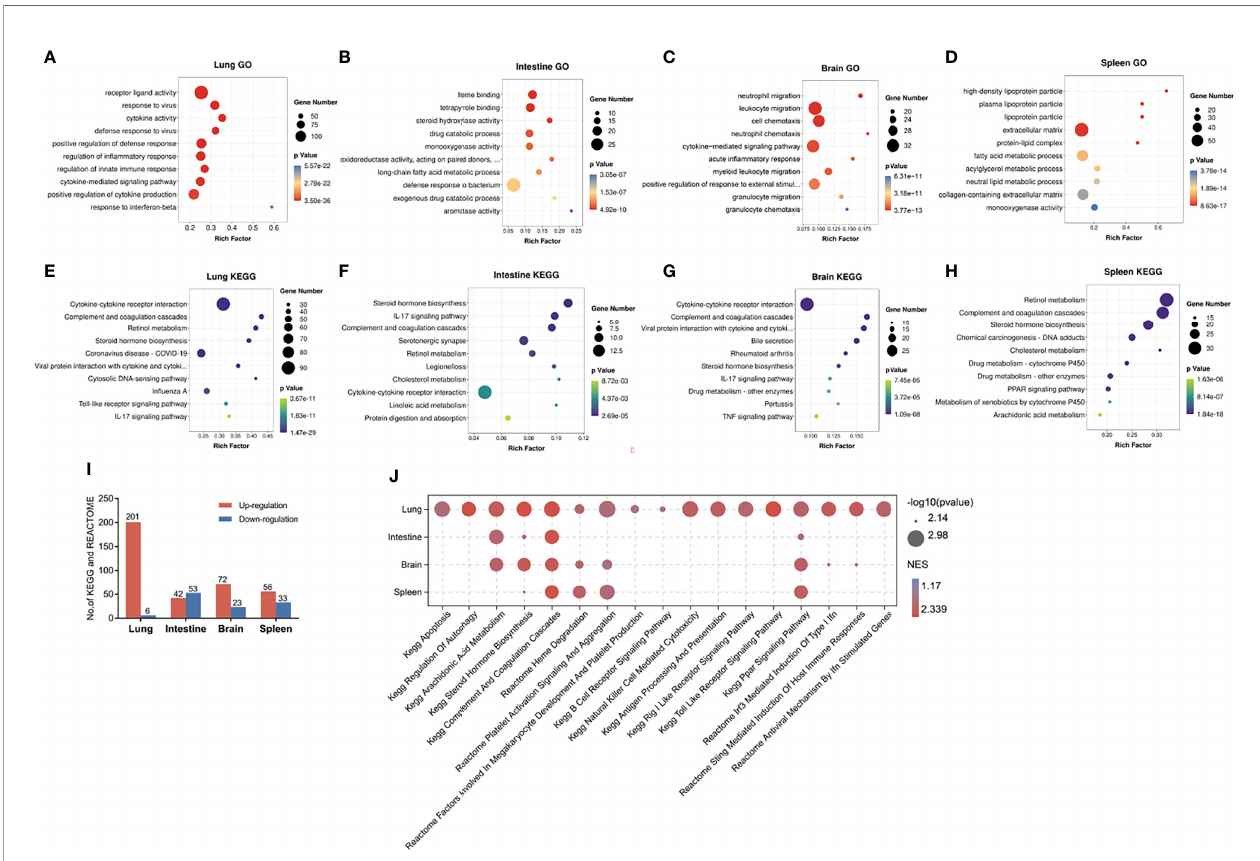
FIGURE 2 | Enrichment analysis of DEGs in lung, intestine, brain, and spleen of RSV-infected mice. (A – D) Top 10 enriched GO terms in DEGs in lung, intestine, brain, and spleen, respectively. (E – H) Top 10 enriched KEGG pathways in DEGs in lung, intestine, brain, and spleen, respectively. An adjusted p- value < 0.05 was considered signi fi cant in GO and KEGG analysis. (I) Distribution of signi fi cantly up- and down-regulated KEGG and Reactome pathways detected by GSEA in four organs ( p < 0.05). (J) Visualization of up-regulated pathways in four organs using OmicShare tools (https://www.omicshare.com/tools). GO, Gene Ontology; KEGG, Kyoto Encyclopedia of Genes and